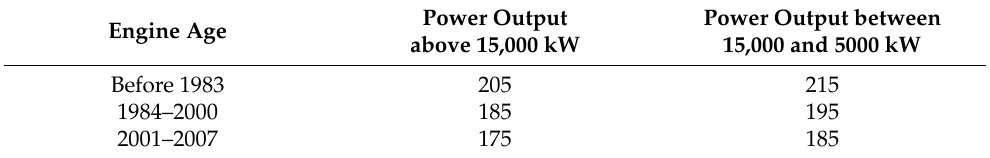
Table 1. SFOC according to the IMO Greenhouse Gas Study 2009.